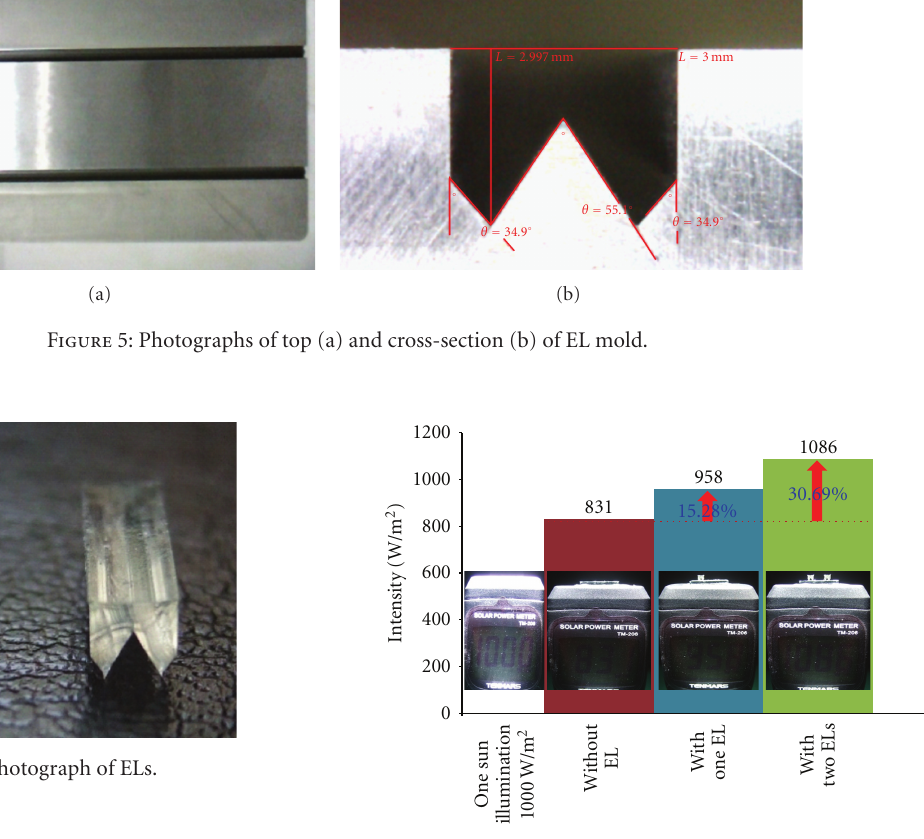
Figure 8: Variations in light intensity of photoelectrode with and without EL under one sun illumination of 1000 W/m 2 (AM